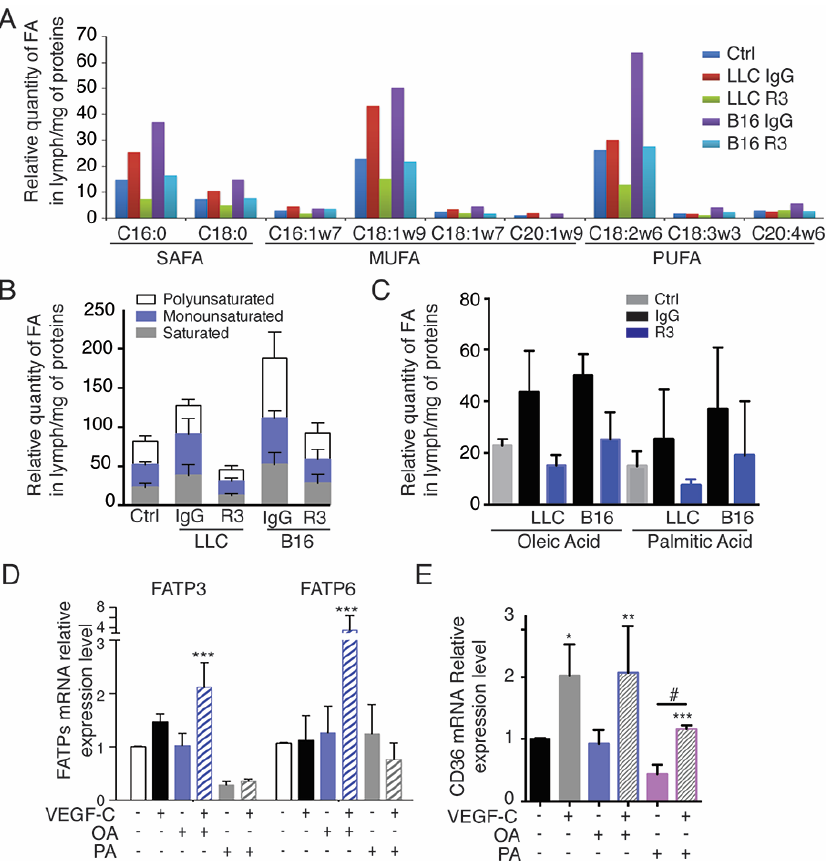
Figure 5. Lipidomic analysis of the lymph from tumor-bearing mice. ( A , B ) Lipidomic analysis of major saturated (SAFA), monounsaturated (MUFA) and polyunsaturated (PUFA) fatty acids in lymph from LLC and B16 tumor-bearing mice treated with IgG control isotype or anti-VEGFR-3 and compared to control mice (C16:0, palmitic acid; C18:0, stearic acid; C16:1w7, palmitoleic acid; C18:1w9, oleic acid; C18:1w7, vaccenic acid; C20:1w9, gondoic acid; C18:2w6, linoleic acid; C18:3w3, g-linoleic acid; C20:w6, arachidonic acid). ( C ) Relative quantification of Oleic Acid (OA, major monounsaturated FFA) and Palmitic Acid (PA, major polyunsaturated FFA) in lymph from LLC- and B16-tumor bearing mice treated with IgG control isotype or anti-VEGFR-3. ( D ) FATP-3 and 6 mRNA expression in OA or PA-stimulated LECs incubated with VEGFC (*** p < 0.001 compared to Ctrl-). ( E ) CD36 mRNA expression in OA or PA-stimulated LECs incubated with VEGFC (# p < 0.001, *** p < 0.001, ** p < 0.01, * p < 0.05 compared to Ctrl −